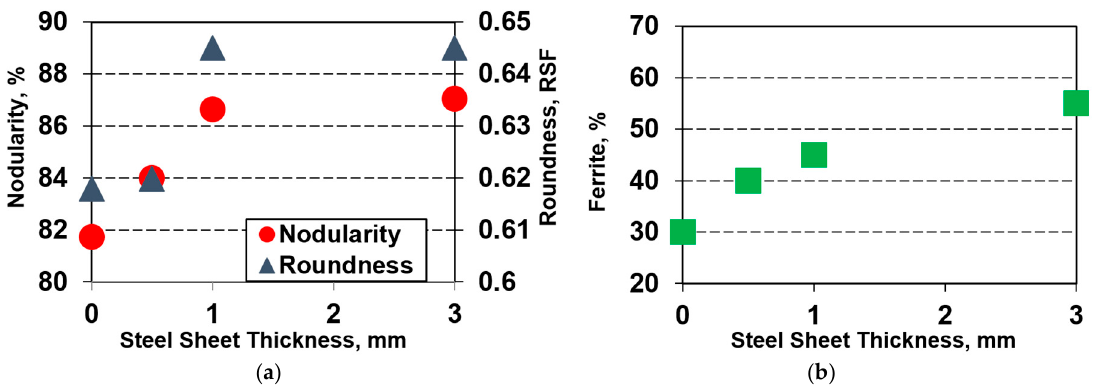
Figure 6. Influence of the steel sheet thickness on the graphite nodularity (N) and graphite roundness shape factor (RSF) ( a ) and ferrite amount ( b ) in the casting body (see Figure 2b).